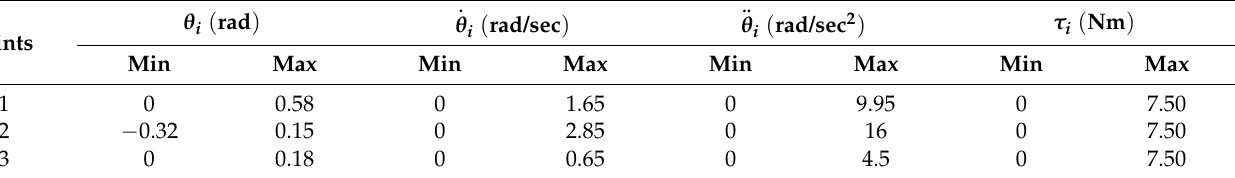
Table 2. Minimum and maximum values of the kinematic and dynamic parameters for a gait